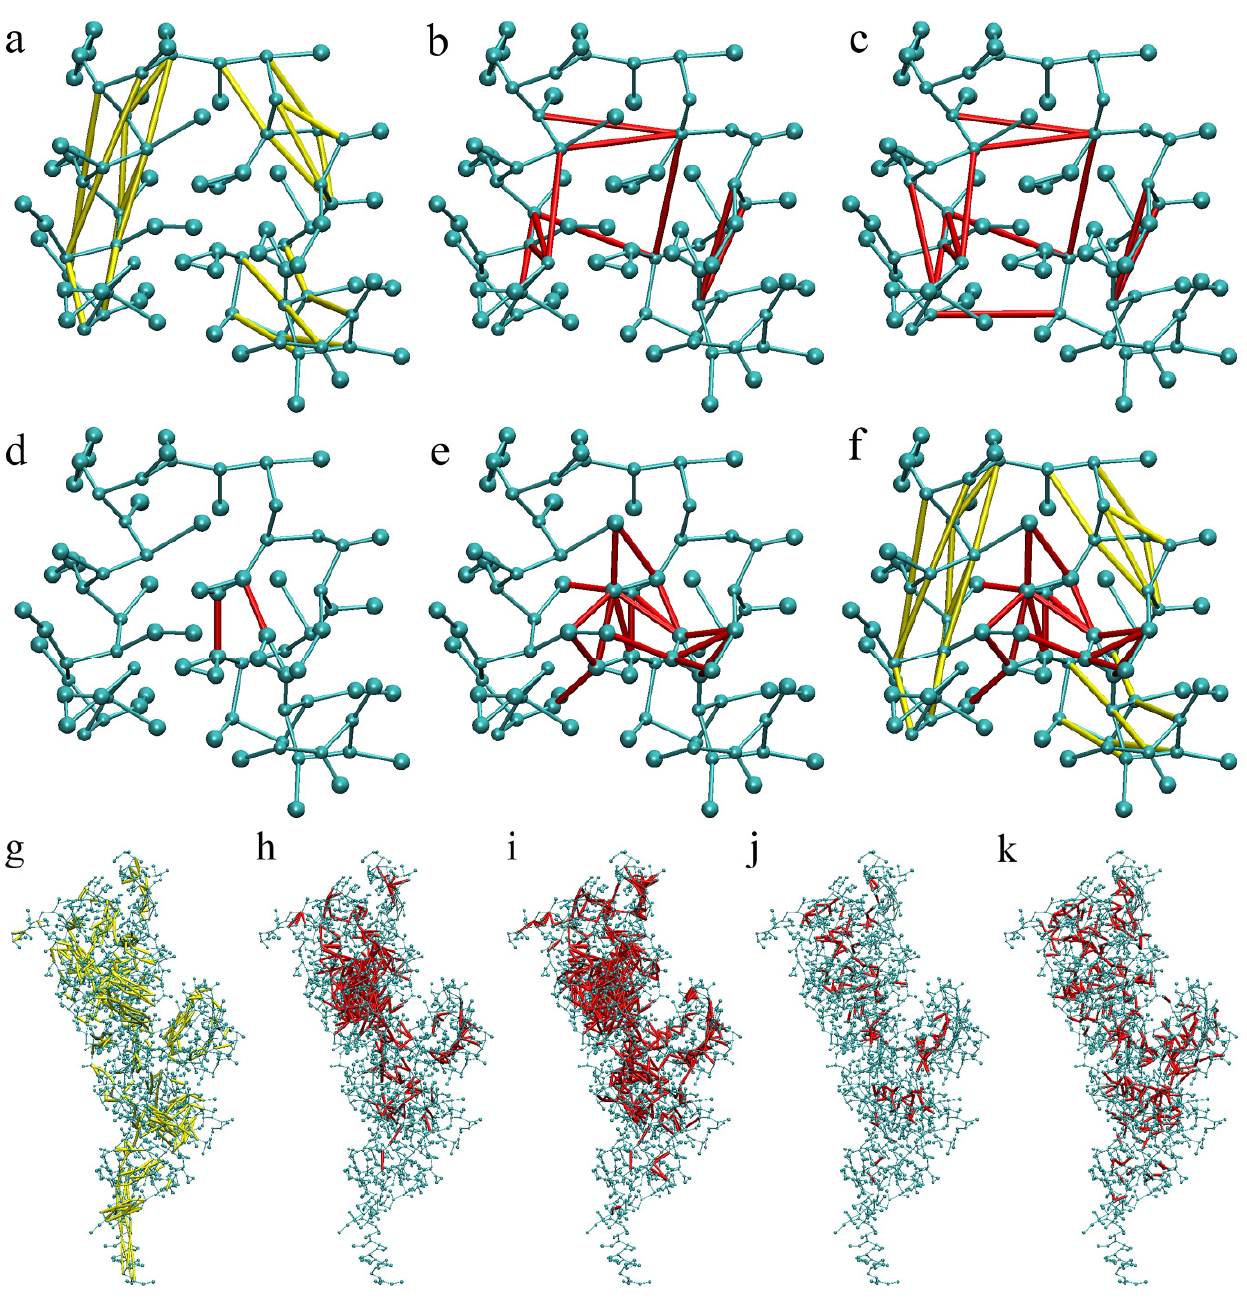
Figure 4. Representation of the SAHBNET network on the villin headpiece subdomain: ( a ) Hydrogen-bond network only; ( b ) BB based network with only SA springs with SA = 30% and R = 0.9 nm; ( c ) SA = 50% and R = 0.9 nm; ( d ) SC based network with c c c c only SA springs with SA = 30% and R = 0.4 nm; ( e ) SA = 30% and R = 0.5 nm; c c c c = 30% and R = 0.5 nm and the networks on PBP1b; ( f ) Complete SAHBNET with SA c c ( g ) Hydrogen-bond network only; ( h ) BB based network with only SA springs with SA = 5% and R = 0.9 nm; ( i ) SA = 30% and R = 0.9 nm, SA SC based network with ( j ) c c c c = 5% and R = 0.5 nm; ( k ) SA = 30% and R = 0.5 nm. Proteins beads are represented SA c c c c in blue, the SA and H-bond springs are represented respectively in yellow and